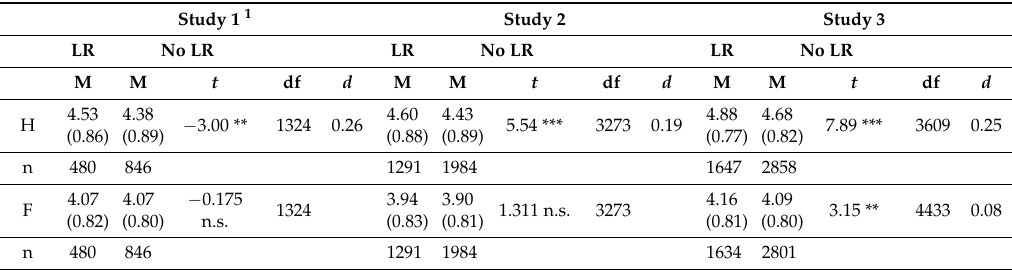
Table 9. Results of Independent Samples t -Tests of Hedgehogness and Foxiness Means of Respondents with and without Leadership